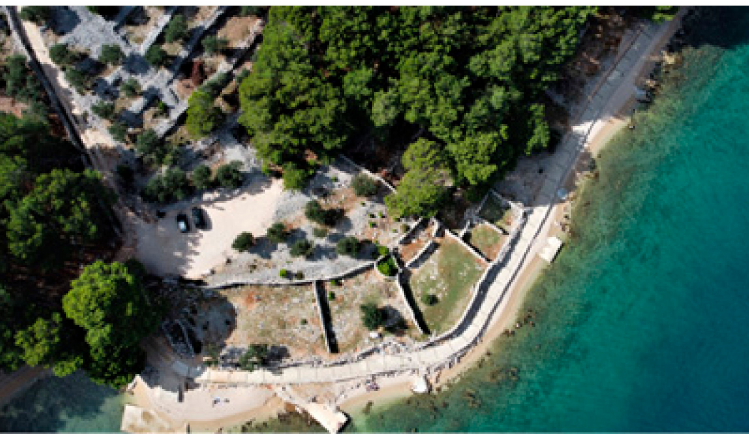
Figure 7. Multicellular sheepfold ( mergar ) within the olive grove (Dražica bay). It is no longer in use (Tanja Kremeni´c,